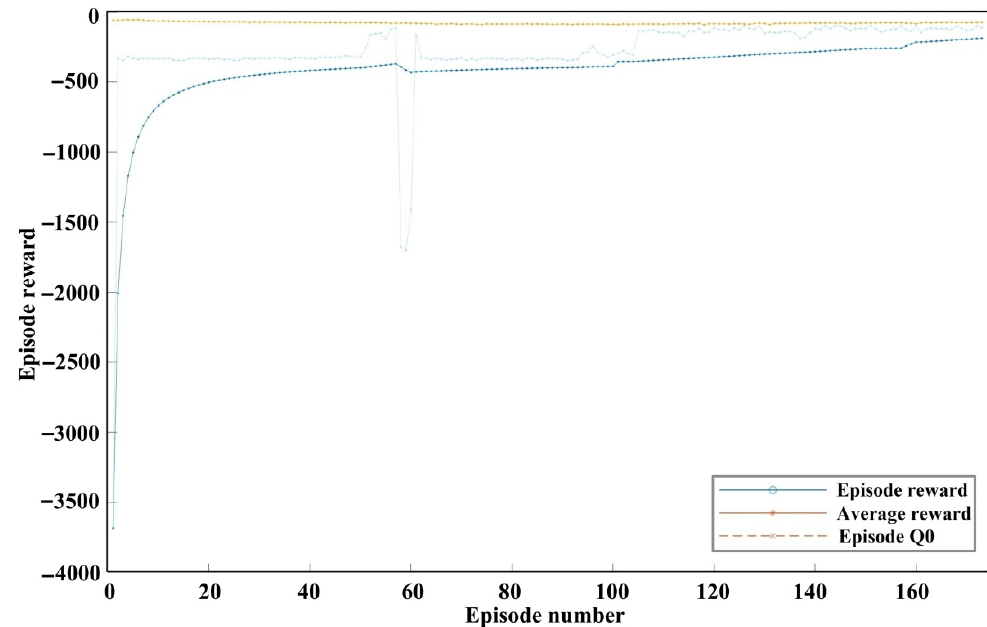
Figure 10. The training stage of the RL-TD3 agent for the correction of the i dref command.